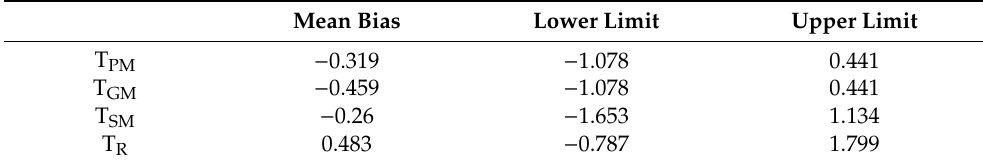
Table A3. Limit of agreement (LOA) of body temperature readings of horses during Phases B (exercise on the treadmill) and D (cool-down